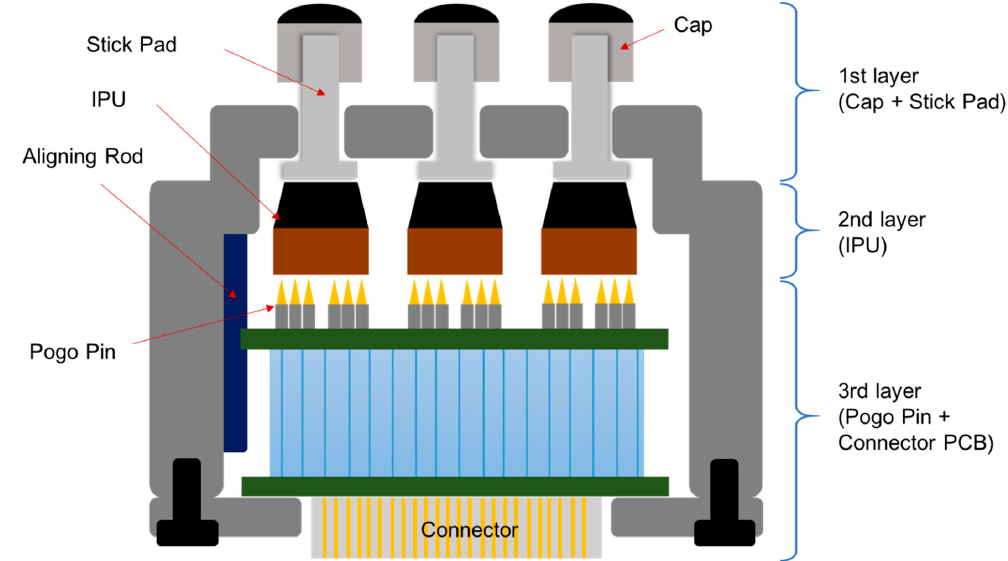
Figure 2. PSRP structure.